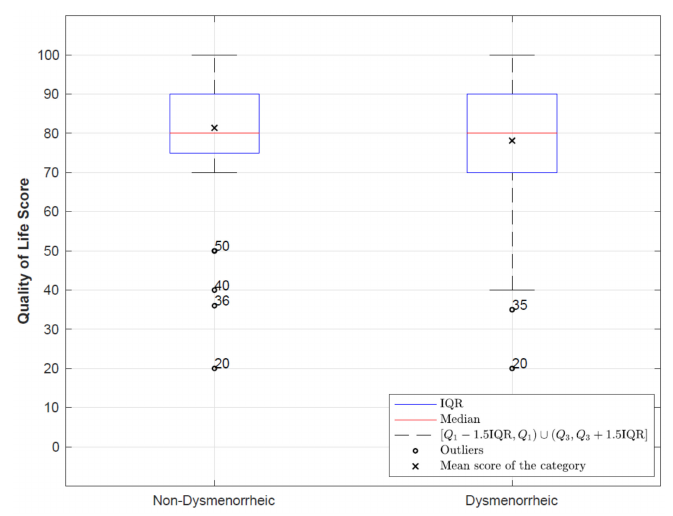
Figure 2. Comparison of the perceived quality of life in the different groups according to the WHO BMI classification.